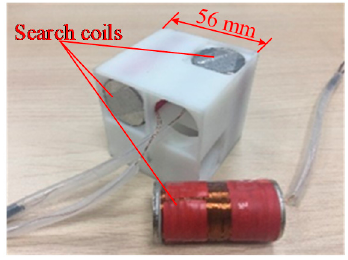
Figure 8. Triaxial search coil sensor.